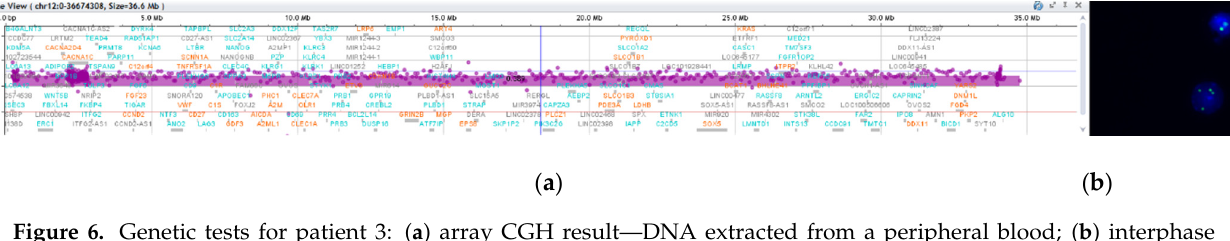
Figure 5. Karyotype for patient 2.